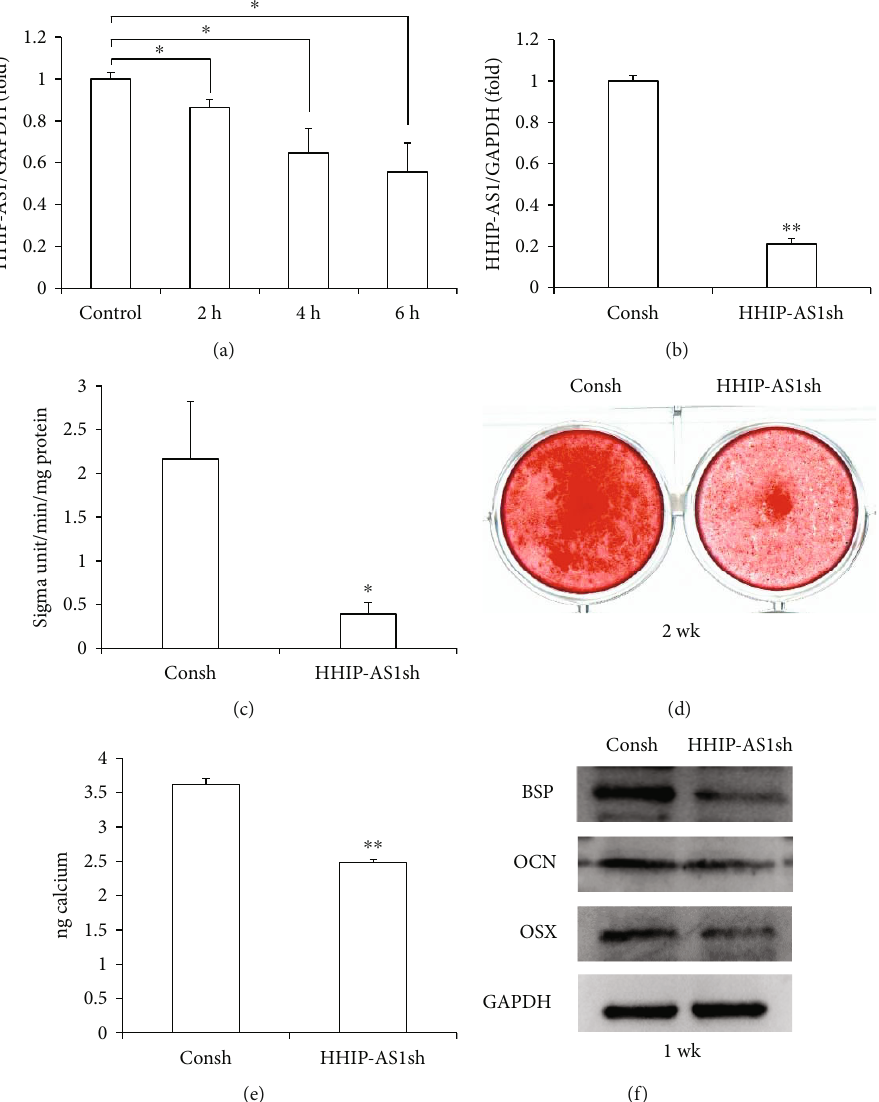
Figure 1: HHIP-AS1 knockdown inhibited the osteogenic di ff erentiation potential of PDLSCs. (a) Real-time RT-PCR result showed the expression level of HHIP-AS1 at 0, 2, 4, and 6 h under continuous compressive pressure. (b) Real-time RT-PCR result showed the knockdown e ffi ciency of HHIP-AS1 in PDLSCs. (c) ALP activity after 5 days of osteogenic induction. (d) Alizarin Red staining result after 2 weeks of osteogenic induction. (e) Calcium quantitative analysis. (f) Western blot results displayed expressions of BSP, OCN, and OSX after 1 week of osteogenic induction. GAPDH was used as internal control in real-time RT-PCR and Western blot. One-way ANOVA or Student ’ s t -test was performed to determine statistical signi fi cance. All error bars represent the SD ( n = 3 ). ∗ P ≤ 0 : 05 ; ∗∗ P ≤ 0 : 01